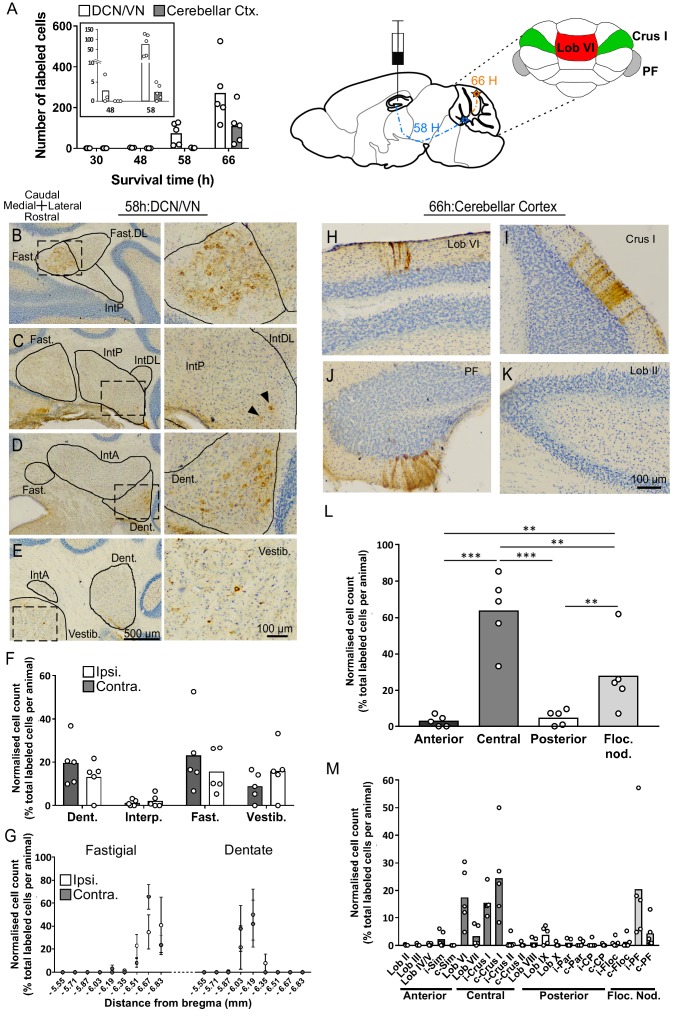
Topographically restricted regions of cerebellar cortex are connected to the hippocampus.(A) Left, mean number of labeled cells in the deep cerebellar nuclei (DCN), vestibular nuclei (VN) and cerebellar cortex at different survival times following rabies injection in left hippocampal dentate gyrus. Box shows a magnification of the labeling at 48 and 58 hr (n = 5 mice for 58 hr and 66 hr, 30 hr, n = 4 mice and 48 hr, n = 3 mice). Middle, schematic representation of rabies injection site and survival times required to reach the cerebellar and vestibular nuclei (58 hr, dashed blue line), and cerebellar cortex (66 hr, orange line). Upper right, schematic view of the posterior cerebellar cortex indicating regions of highest labeling following rabies virus injection (red, vermis lobule VI; green, Crus I; gray, paraflocculus). (B-E) Representative photomicrographs showing labeling in the cerebellar and vestibular nuclei 58 hr post-infection. Left panels show low-magnification view, right panels show magnified view of area indicated by dashed box. Solid arrow heads indicate the presence of the very few labeled cells in the IntP. (F) Pooled, normalized counts of rabies labeled cells in the ipsi- and contralateral cerebellar and vestibular nuclei 58 hr post-infection (n = 5 mice). No significant differences were found between ipsi- and contralateral nuclei (nuclei x hemisphere two-way ANOVA, hemisphere effect F (1, 4)=1.31×10−5, p=0.99, interaction effect F (3, 12)=2.79, p=0.09, nuclei effect F (3, 12)=9.38, p=0.002). (G) Normalized cell counts in the fastigial nucleus (left) and dentate nucleus (right), according to their rostro-caudal position relative to bregma. Open circles, contralateral count; filled circles, ipsilateral count (n = 5 mice). (H-K) Representative photomicrographs of the resultant labeling in lobule VI, Crus I, paraflocculus and lobule II at 66 hr post-infection. (L) Normalized count of rabies labeled cells in anterior (black bar; lobule II to lobule IV/V); central (dark gray bar; lobule VI to Crus II); posterior (clear bar; lobule VIII and lobule IX) and flocculonodular (Floc. Nod., light gray bar; lobule X, flocculus and paraflocculus) cerebellum 66 hr post-infection (n = 5 mice; one-way ANOVA with FDR correction, F (3, 16)=19.11, p<0.0001). (M) Normalized cell count of rabies labeled cells in all assessed lobules 66 hr post-infection. Color coding of bars indicate assignment of lobules to either anterior, central, posterior or vestibular cerebellum as indicated in L. Abbreviations: Dent., Dentate nucleus; Fast., fastigial nucleus; Fast. DL, dorsolateral fastigial nucleus; Floc. Nod., flocculonodular lobe; Interp., nucleus interpositus; IntA, nucleus interpositus anterior; IntDL, dorsolateral nucleus interpositus; IntP, nucleus interpositus posterior; i-Sim, ipsilateral simplex lobule; c-Sim, contralateral simplex lobule; i-Crus I, ipsilateral Crus I; c-Crus I, contralateral Crus I; i-Crus II, ipsilateral Crus II; c-Crus II, contralateral Crus II; i-Par, ipsilateral paramedian lobule; c-Par, contralateral paramedian lobule; i-CP, ipsilateral copula; c-CP, contralateral copula; i-Floc, ipsilateral flocculus; c-Floc, contralateral flocculus; i-PF, ipsilateral paraflocculus; c-PF, contralateral paraflocculus; Vestib., vestibular nuclei. ** q < 0.01, *** q < 0.001.10.7554/eLife.41896.008Figure 1—source data 1.Summary table of RABV labeling in the cerebellum 58 hr post hippocampal infection.Quantification of the number of rabies-positives cells in the ipsi- (i.) and contra-lateral (c.) side of the cerebellar cortex, the deep cerebellar and vestibular nuclei. Nu, nucleus; Lob, lobule; pm, paramedian lobe; cop, copula pyramidis.